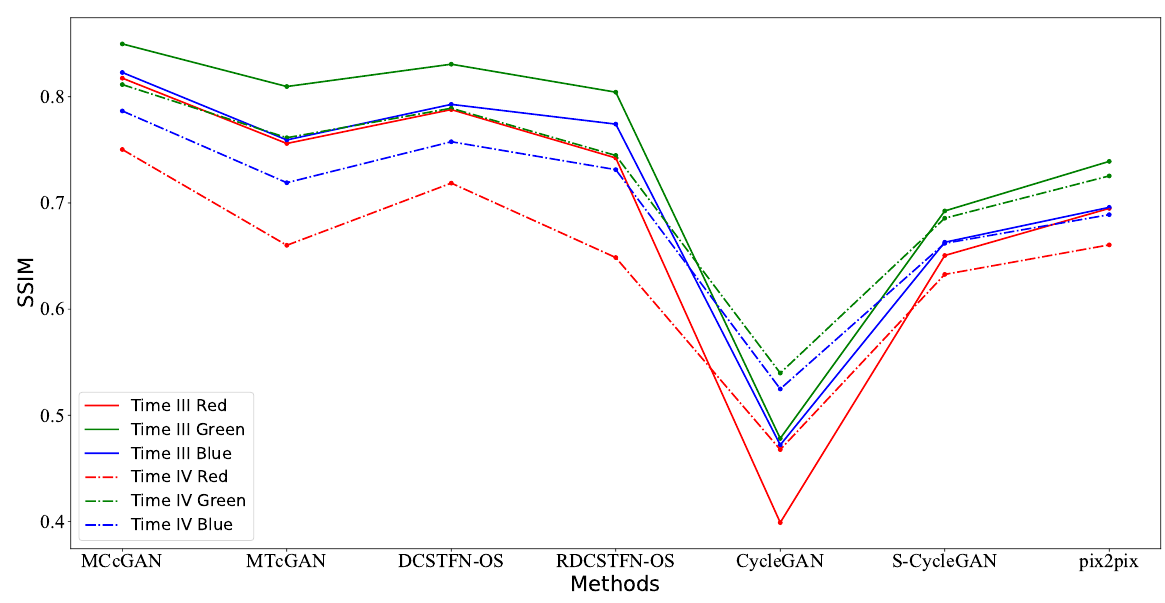
Figure 7. The RMSE results of different methods for different bands in Area B at Times III and IV.